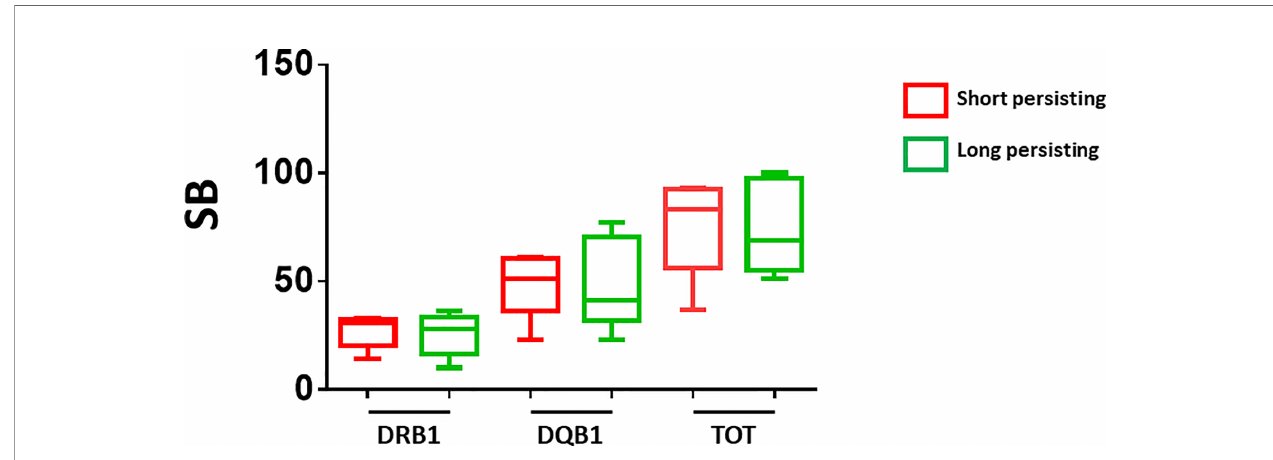
FIGURE 5 | Number of predicted SB in short- and long-persisting vaccinees. The number of strong binders (SB) are indicated for the vaccinees who showed Ab titers persisting at maximum (2,500 BAU/ml) after 4 months (long persisting) and those who showed Ab titers rapidly declining from the maximum after 4 months (short